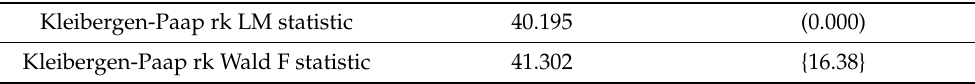
Table 4. Weak Instrumental Variables Test.